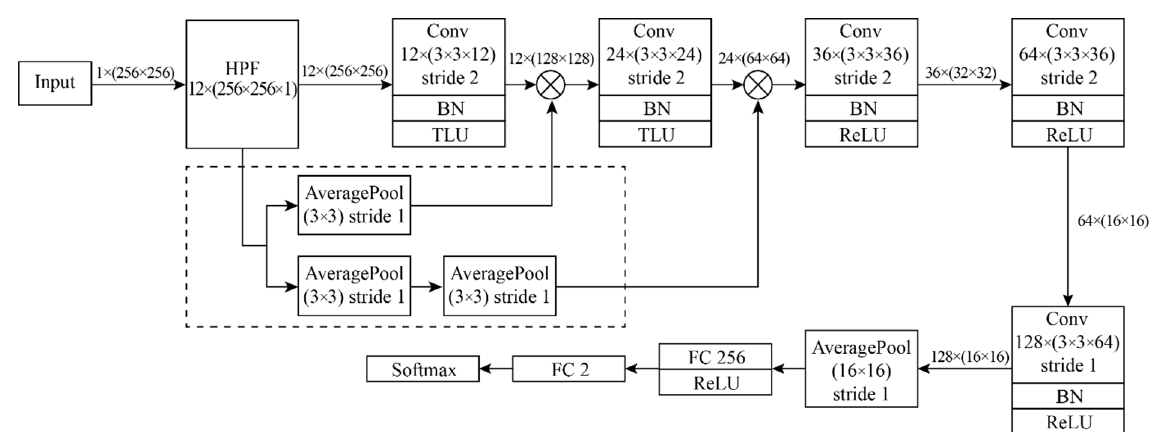
Figure 4. Structure of HPF-Enhanced Model.